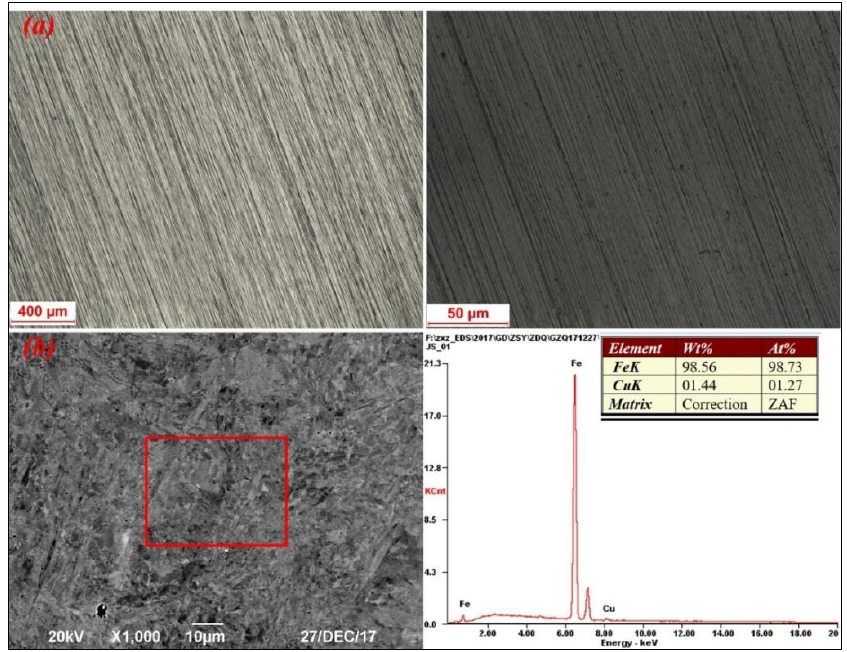
Figure 13. SEM-EDS and microstructure of Fe – Cu alloy.